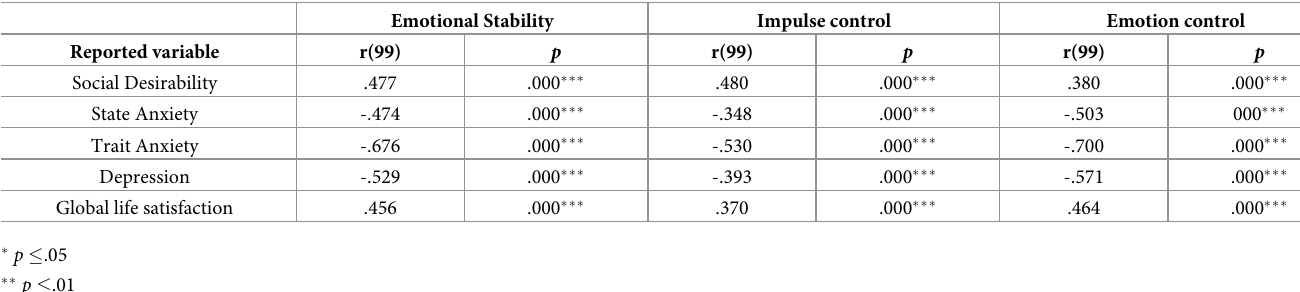
Table 4. Statistical results of correlation analysis between emotional stability, and its subdimensions, with the other self-report variables. Emotional Stability Impulse control Emotion